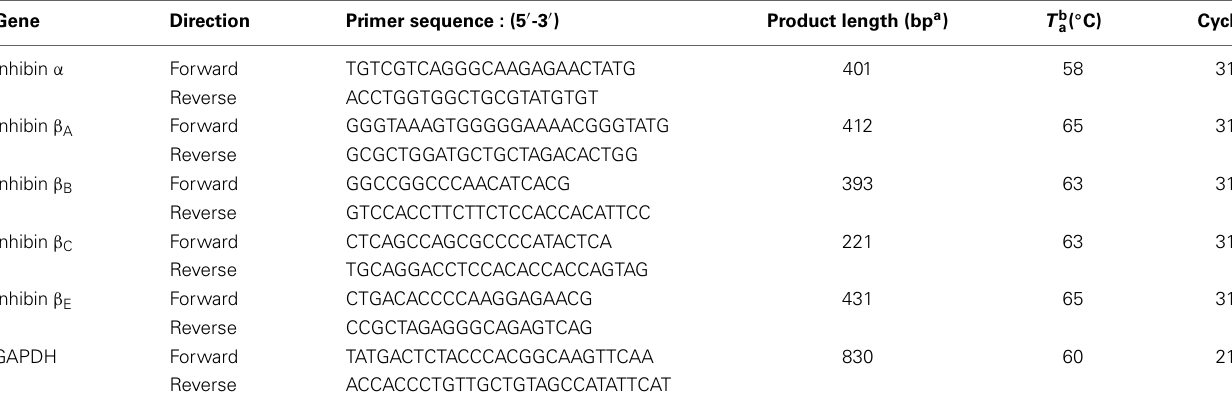
Table 1 | Primers used for RT-PCR analysis of gene expression, and PCR experimental condition.